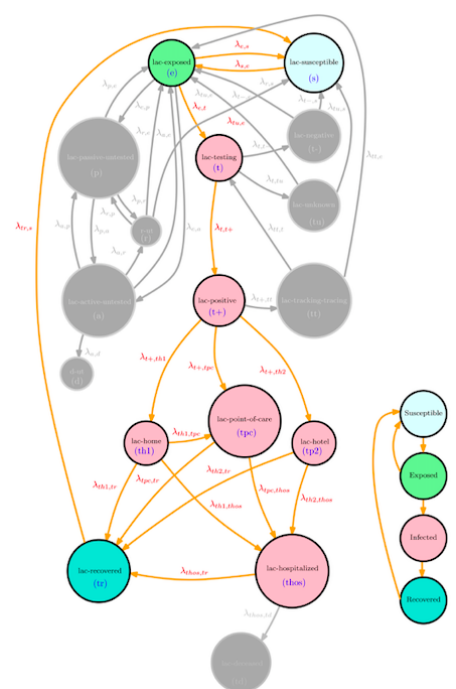
Figure 9. Connection of the dynamics of